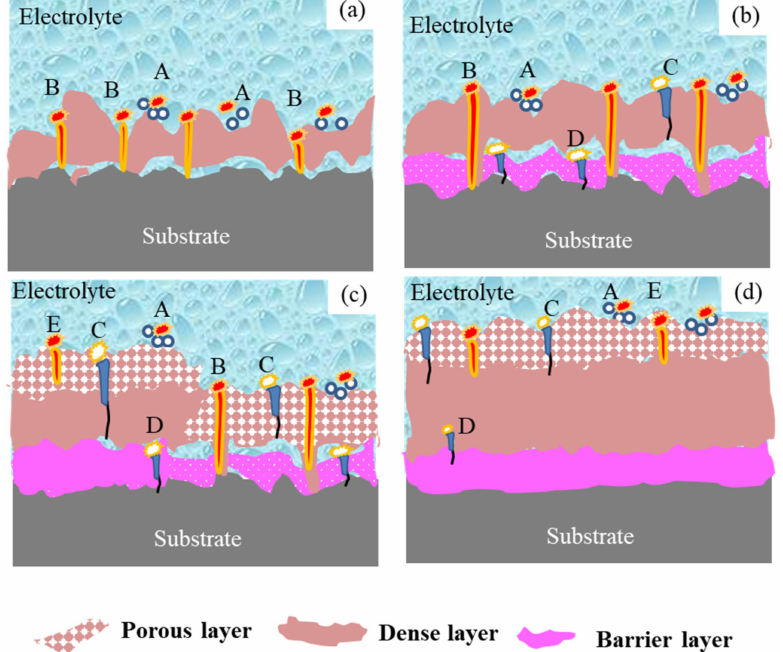
Figure 4. Schematic diagram of discharge type transitions forming a dense and uniform single layer: ( a ) stage II; ( b ) stage III; ( c ) early period of stage IV; ( d ) later period of stage